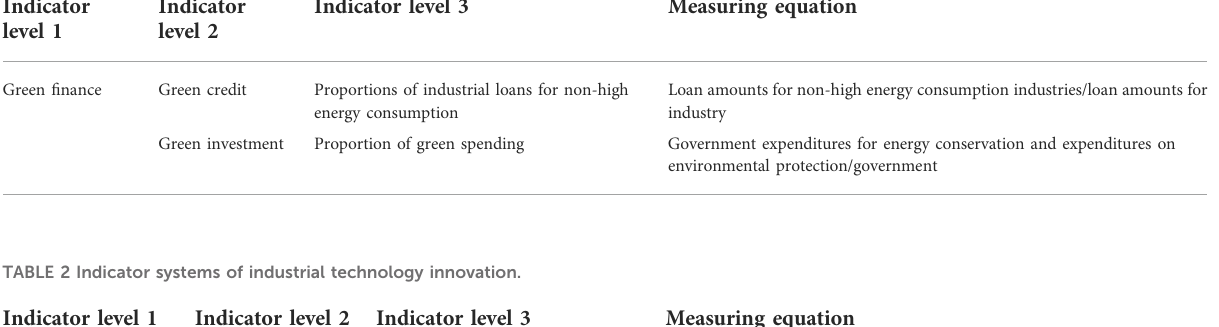
TABLE 2 Indicator systems of industrial technology